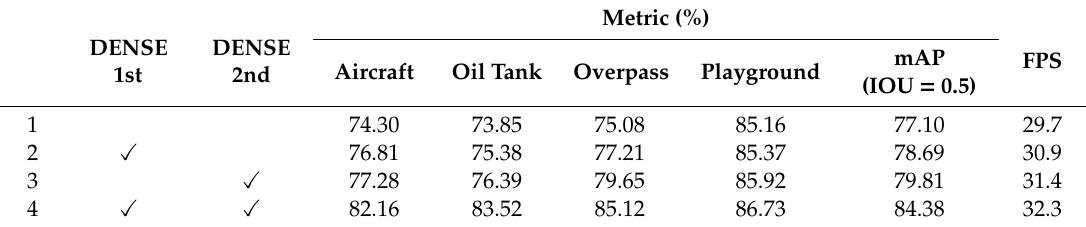
Table 10. Experimental comparisons of each combination in the feature extraction network.